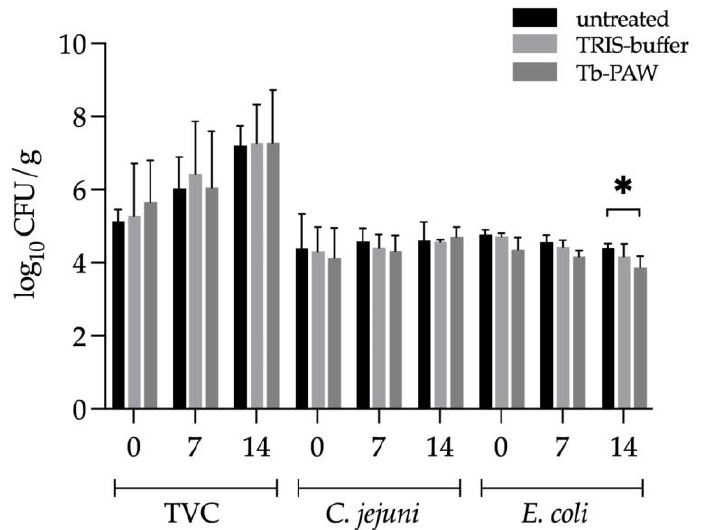
Figure 4. Reduction of the total viable count (TVC), Campylobacter (C.) jejuni and Escherichia (E.) coli on duck carcasses either with or without Tb-PAW/TRIS-buffer treatment. Untreated and treated breasts (TVC) and thighs ( C. jejuni and E. coli ) with skin were stored in modified atmosphere packages (30% CO 2 , 70% N 2 ) at 4 °C for 14 days. The samples from day 0 were analyzed on the packaging day, the others accordingly without re-treatment on days 7 and 14. Results represent the mean ± standard deviation. Significant differences are defined as * p ≤ 0.05. Tb-PAW = TRIS-buffered plasma-activated water.